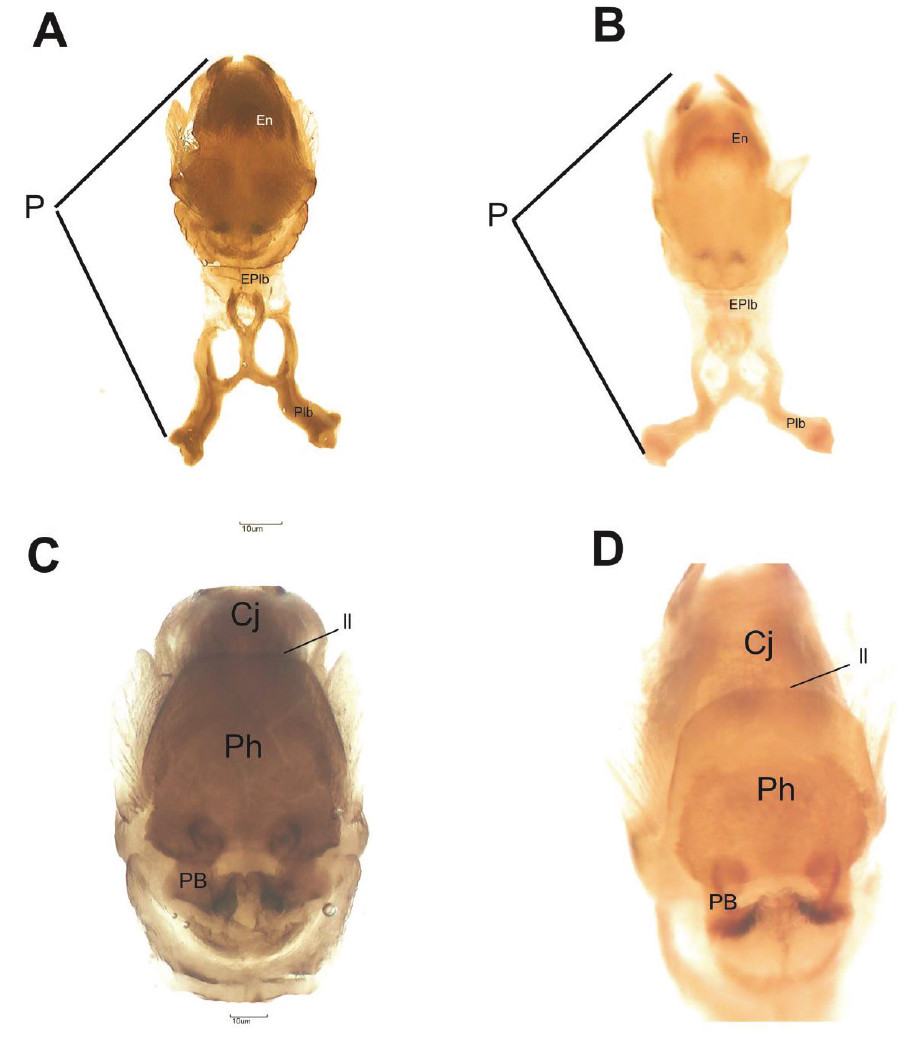
Figure 8. Phallus of R. taquarussuensis sp. n. A dorsal view C ventral view, R. neglectus B dorsal view D ventral view. Cj: conjunctive, En: endosome, EPlb: median extencion of basal plate, P: phallus, Plb: basal plate, PrG: gonopore process, PrPh: phallossoma process, Ph: phallosoma, PrCj: conjunctive pro- cess, ll: line